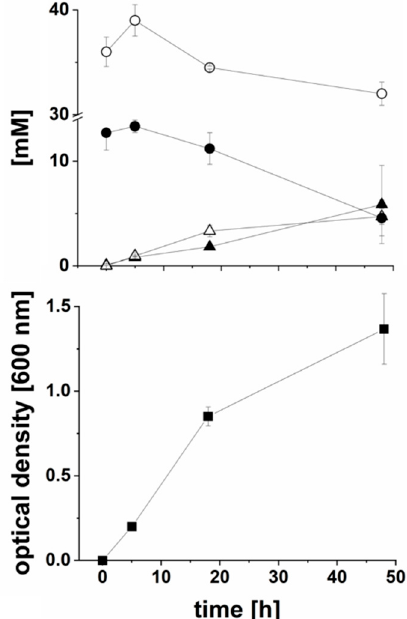
Figure 1. Consumption of glucose and formation of carboxylic acids during anaerobic growth of P. bivia . Upper panel: concentrations of glucose (closed circles), acetate (open circles), succinate (closed triangles), and malate (open triangles). Lower panel: optical density at 600 nm. Average and standard deviations of three biological replicates are shown.